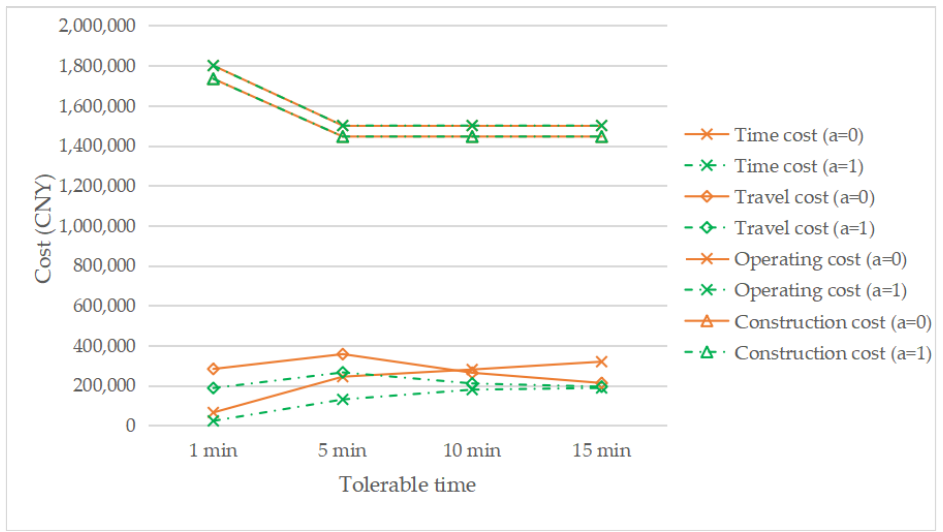
Figure 12. The change of cost components with changing the tolerable time.